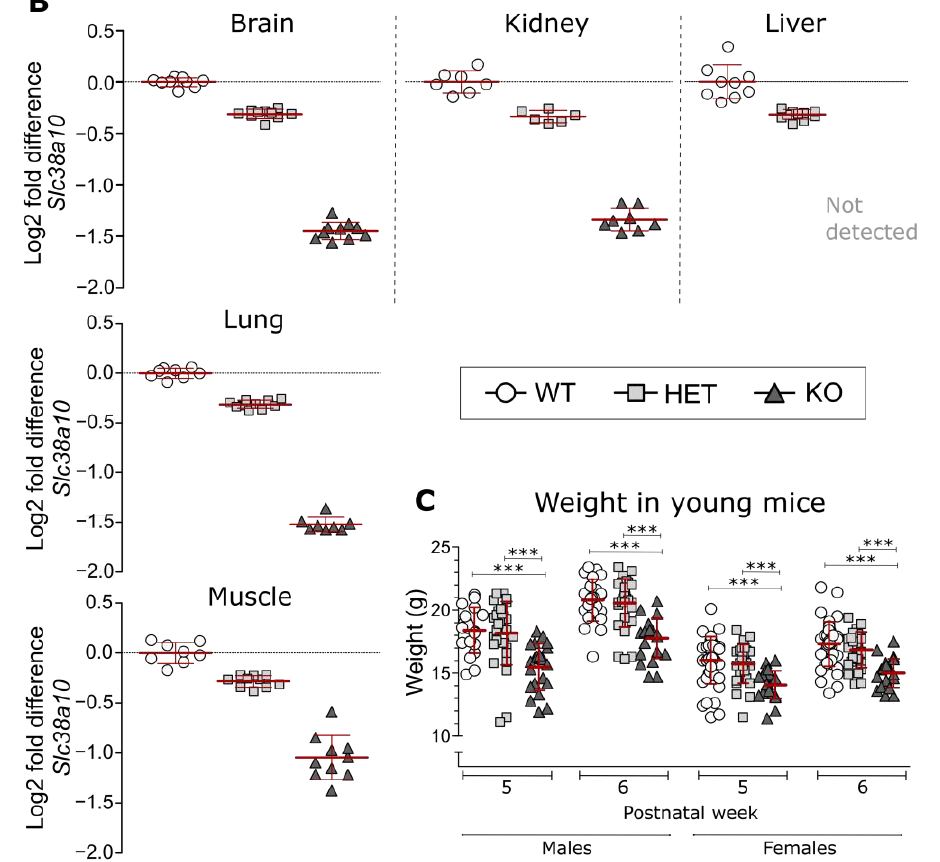
Figure 1. Display of β -galactosidase expression, Slc38a10 gene expression and weight in SLC38A10- deficient mice. ( A ) Indirect staining of the β -galactosidase protein (encoded by the LacZ gene), showing the promotor activity in the genetically modified male and female mice, respectively, as well as lack of staining in the WT control. ( B ) Slc38a10 relative expression in brain, kidney, liver, lung, and muscle from WT, HET and KO mice were measured by RT-qPCR using two to three reference genes. Expression is presented as a log2 fold change compared to the mean of the WT group. Analysis was conducted with one-way ANOVA with correction for multiple testing (according to qbase+ software version 3.2, Biogazelle, Zwijnaarde, Belgium—https://www.qbaseplus.com, accessed 25 May 2022). ( C ) Weight differences between young WT (n = 25 males; 45 females), HET (n = 29 males; 28 females) and KO (n = 22 males; 23 females) mice. Analysis was conducted with a two-way ANOVA (repeated measures) with Bonferroni correction, *** = p <